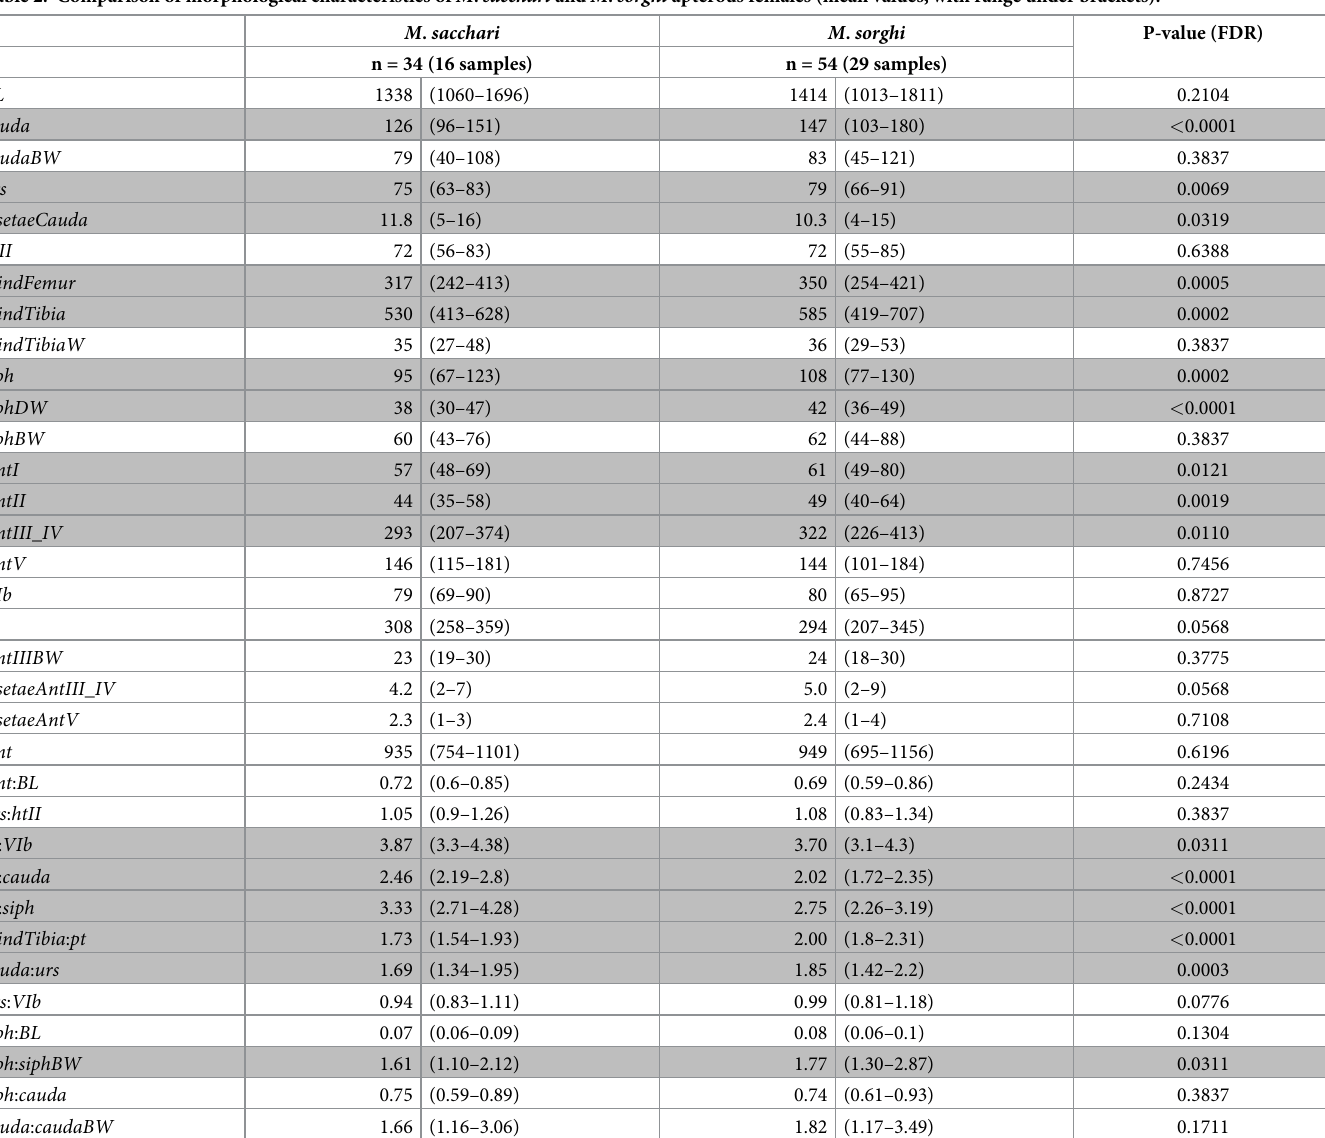
Table 2. Comparison of morphological characteristics of M . sacchari and M . sorghi apterous females (mean values, with range under